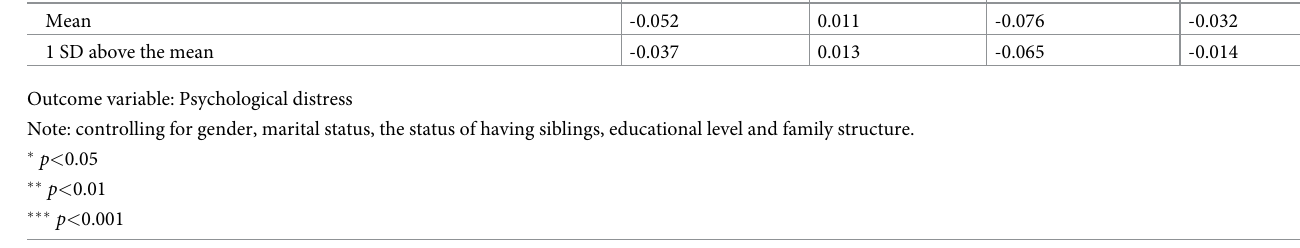
Note : controlling for gender, marital status, the status of having siblings, educational level and family structure. �� P < 0.01. ���